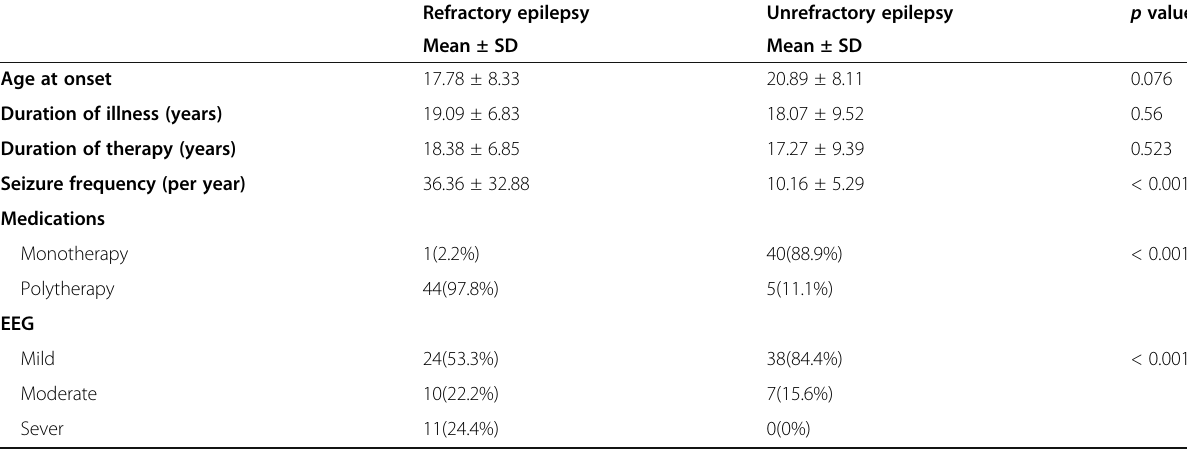
Table 2 Clinical and medications variables among the studied samples